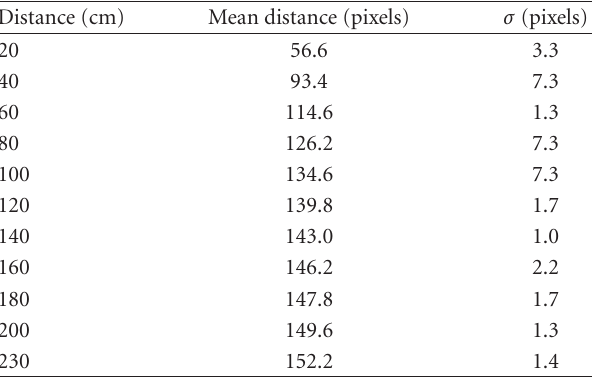
Table 5: Distance calibration data using mobile object detection.